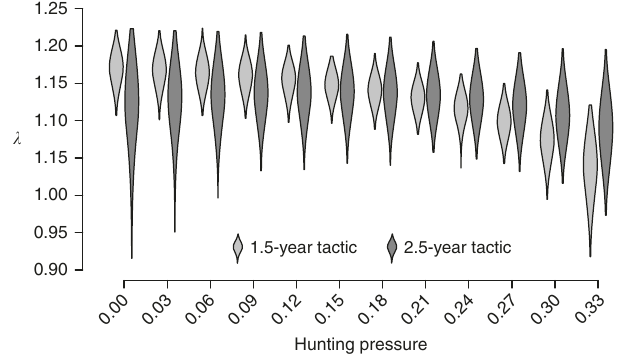
Fig. 5 Hunting-induced change in the occurrence of brown bear maternal care tactics. Predicted effect of hunting pressure (number of marked bears that were shot in a given year divided by the number of marked bears available for hunting that same year) on the asymptotic population growth rate, λ , for each maternal care tactic using longitudinal data on female brown bears from 1993 to 2015 in south-central Sweden. The violins represent the density plots of lambda (1000 iterations) at each hunting pressure simulated. Estimates of the effect of hunting pressure on tactic- and age class-speci fi c survival probabilities are given in